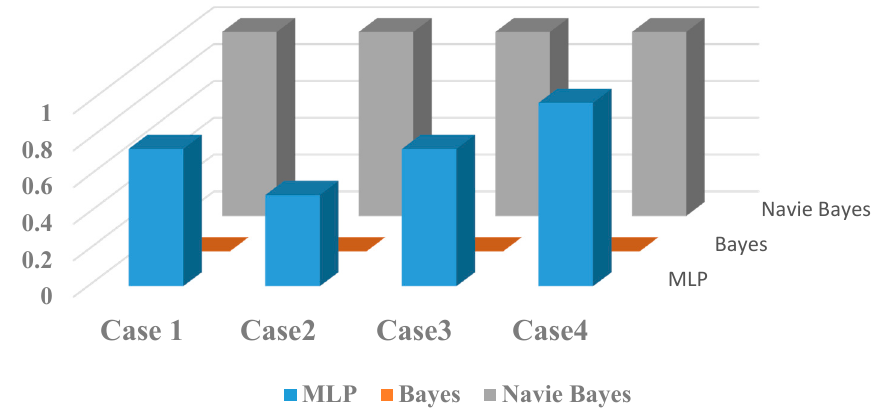
Figure 15. KappaStatistics comparison of various classifiers.